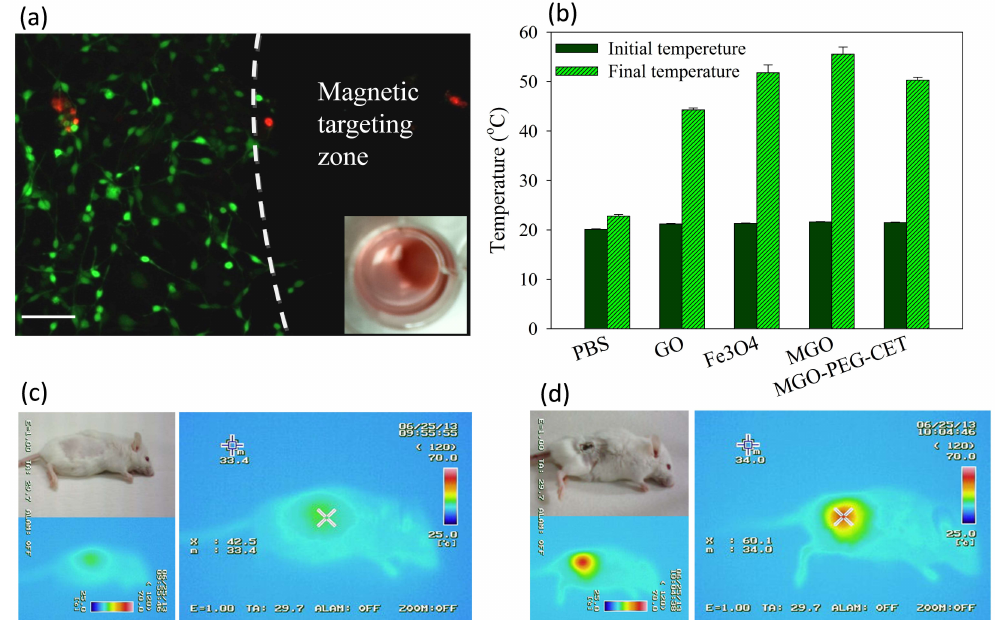
Figure 7. ( a ) Live/Dead staining of CT-26 cells after contacting with MGO-PEG-CET/DOX in a cell culture dish with a magnetic targeting zone created in a well of a culture dish by placing a magnet at the bottom of the well. The insert shows that MGO-PEG-CET/DOX was guided to the right corner of the well in the culture dish. Green: live cells; red: dead cells. Bar = 100 µ m; ( b ) Temperature changes in vitro after exposure different nanocarriers (1 mg/mL in 0.2 mL of PBS) to NIR light at 2.5 W/cm 2 for 3 min. The in vivo temperature rise from thermal imaging of healthy BALB/c mouse ( c ) and tumor-bearing mouse ( d ) after intravenous injection of MGO-PEG-CET (7 mg/kg), followed by guidance with a magnetic field (1400 Gauss) for 2 h and exposure to NIR light (2.5 W/cm 2 for 5